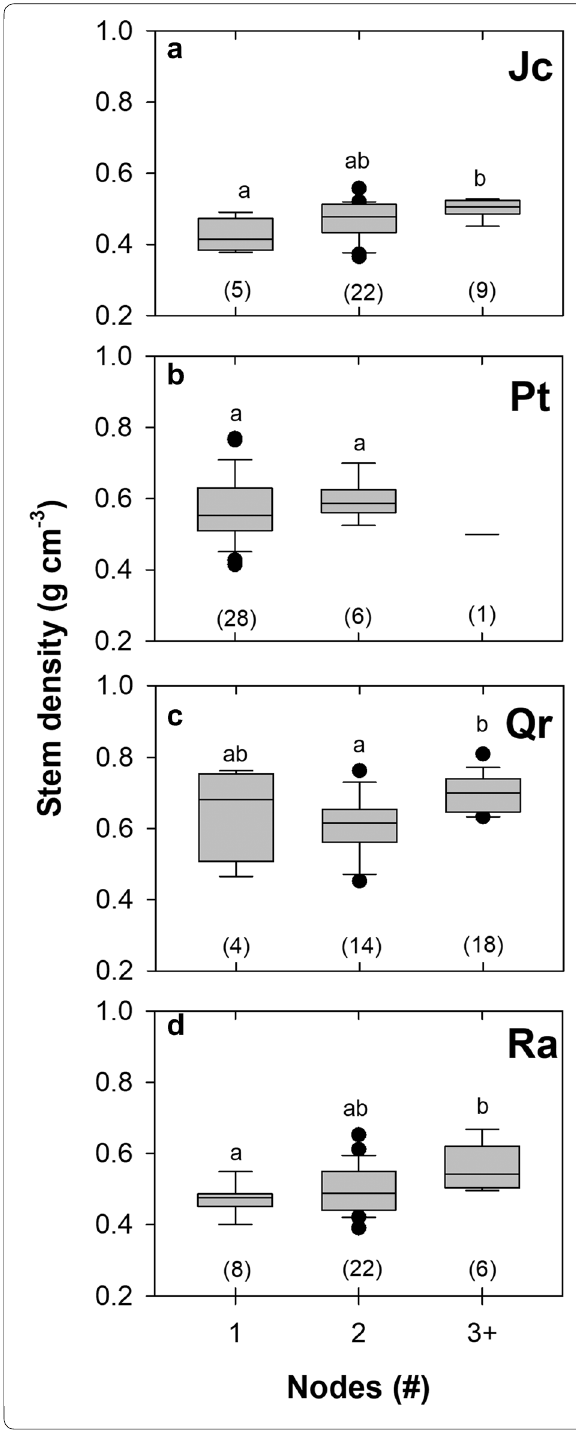
Fig. 6 Stem density of 5-cm stem segments that included 1, 2, and 3 or more (3 ) nodes within the segment. For each box (grey), + the center line represents the median, the grey box represents 25 and 75% data boundaries, the whiskers represent 10 and 90% data boundaries, and black circles represent the 5 and 95% data boundaries. For some species and node numbers, sample sizes precluded the calculation of all of these parameters. Same sizes are included for each box in the parentheses within a panel. For three species, there were significant differences in stem density among segments with different numbers of nodes (Jc F 2,33 3.60 P 0.038, = = Qr F 2,33 5.82 P 0.007, and Ra F 2,33 3.44, P 0.044) and there = = = = was no differences for the fourth species (Pt F 2,33 0.65 P 0.530). = = Within a panel, different letters indicate significant differences in stem density with the number of nodes. Species abbreviations are included in Table